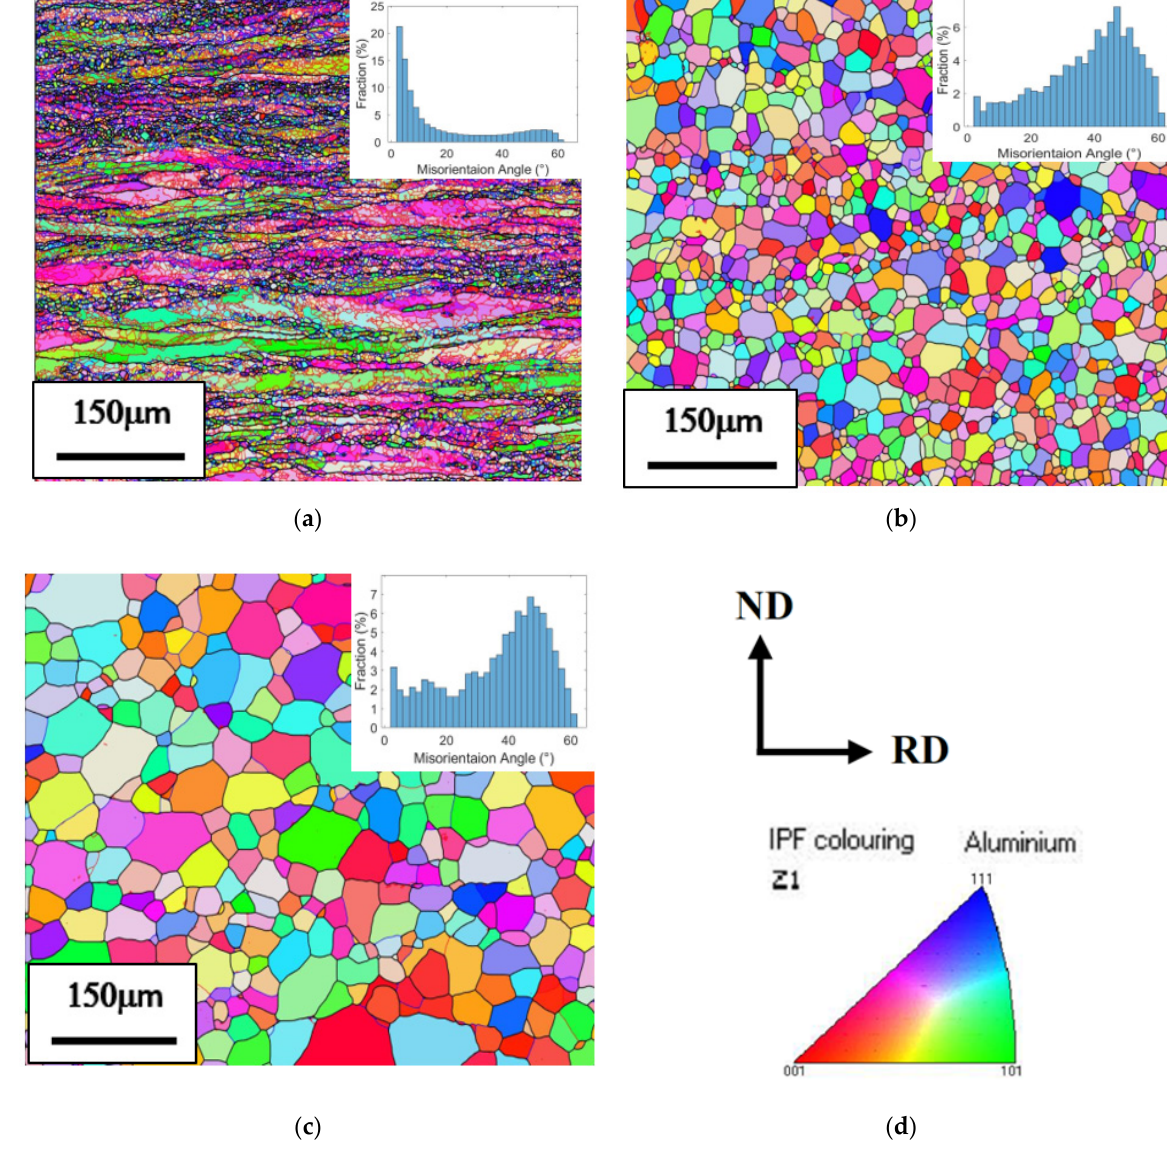
Figure 3. Grain orientation micrographs and the grain boundary angle bar graph under different annealing processes: ( a ) alloy A annealed at 250 ◦ C; ( b ) alloy A annealed at 350 ◦ C; ( c ) alloy A annealed at 450 ◦ C; ( d ) IPF (Inverse Pole Figure) coloring map and cross-sectional direction. ND, normal direction; RD, rolling